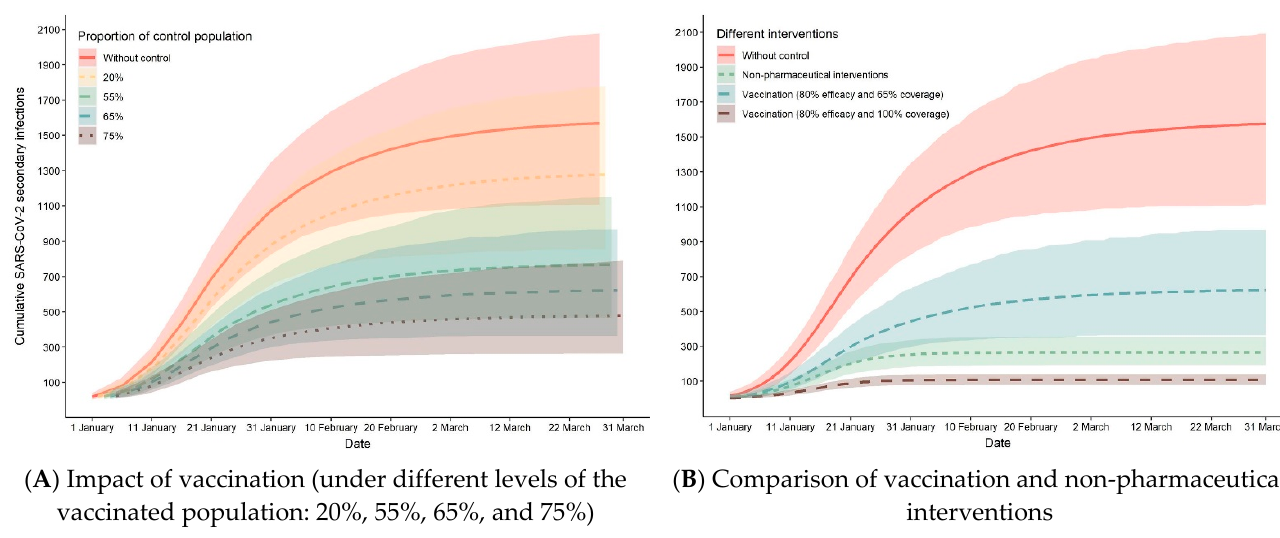
Figure 2. Comparison of NPIs and vaccination in SARS-CoV-2 transmission.